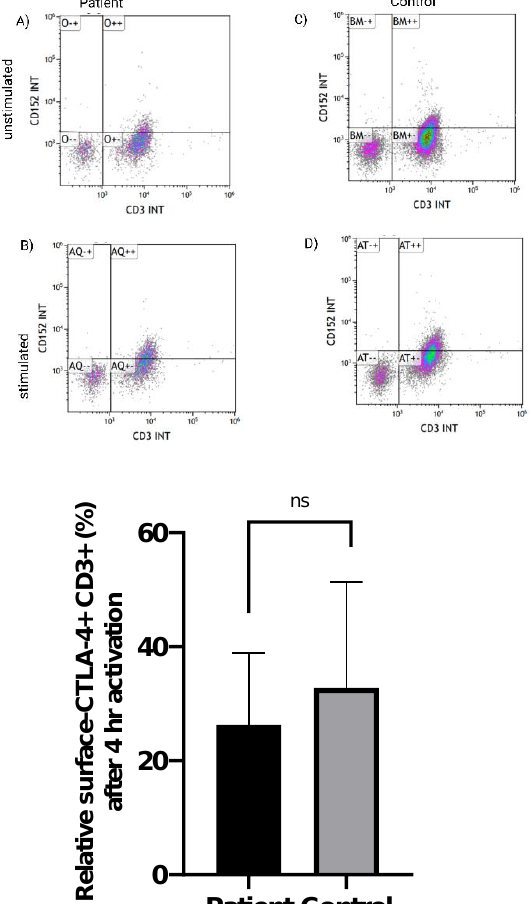
Figure 2. Relative CTLA-4 expression, gated on CD3+ cells. The expression of CTLA-4 on the surface of CD3+ T-cells in the proband, 4 h following activation, was none-significantly different ( p = 0.642) compared to the control. The median between two groups was compared using Mann-Whitney U test. Error bars represent standard error of the means ( ± SEM). ns: non significant. Paired parametric t test was used. The flowcytometry images represent the CD3+ CTLA-4+ T cells in ( A ) basal level and ( B ) after 4 h of stimulation with PMA/ionomycin in the proband. ( C , D ) represent the flowcytometry in the healthy control at the basal and after 4 h of stimulation, respectively.